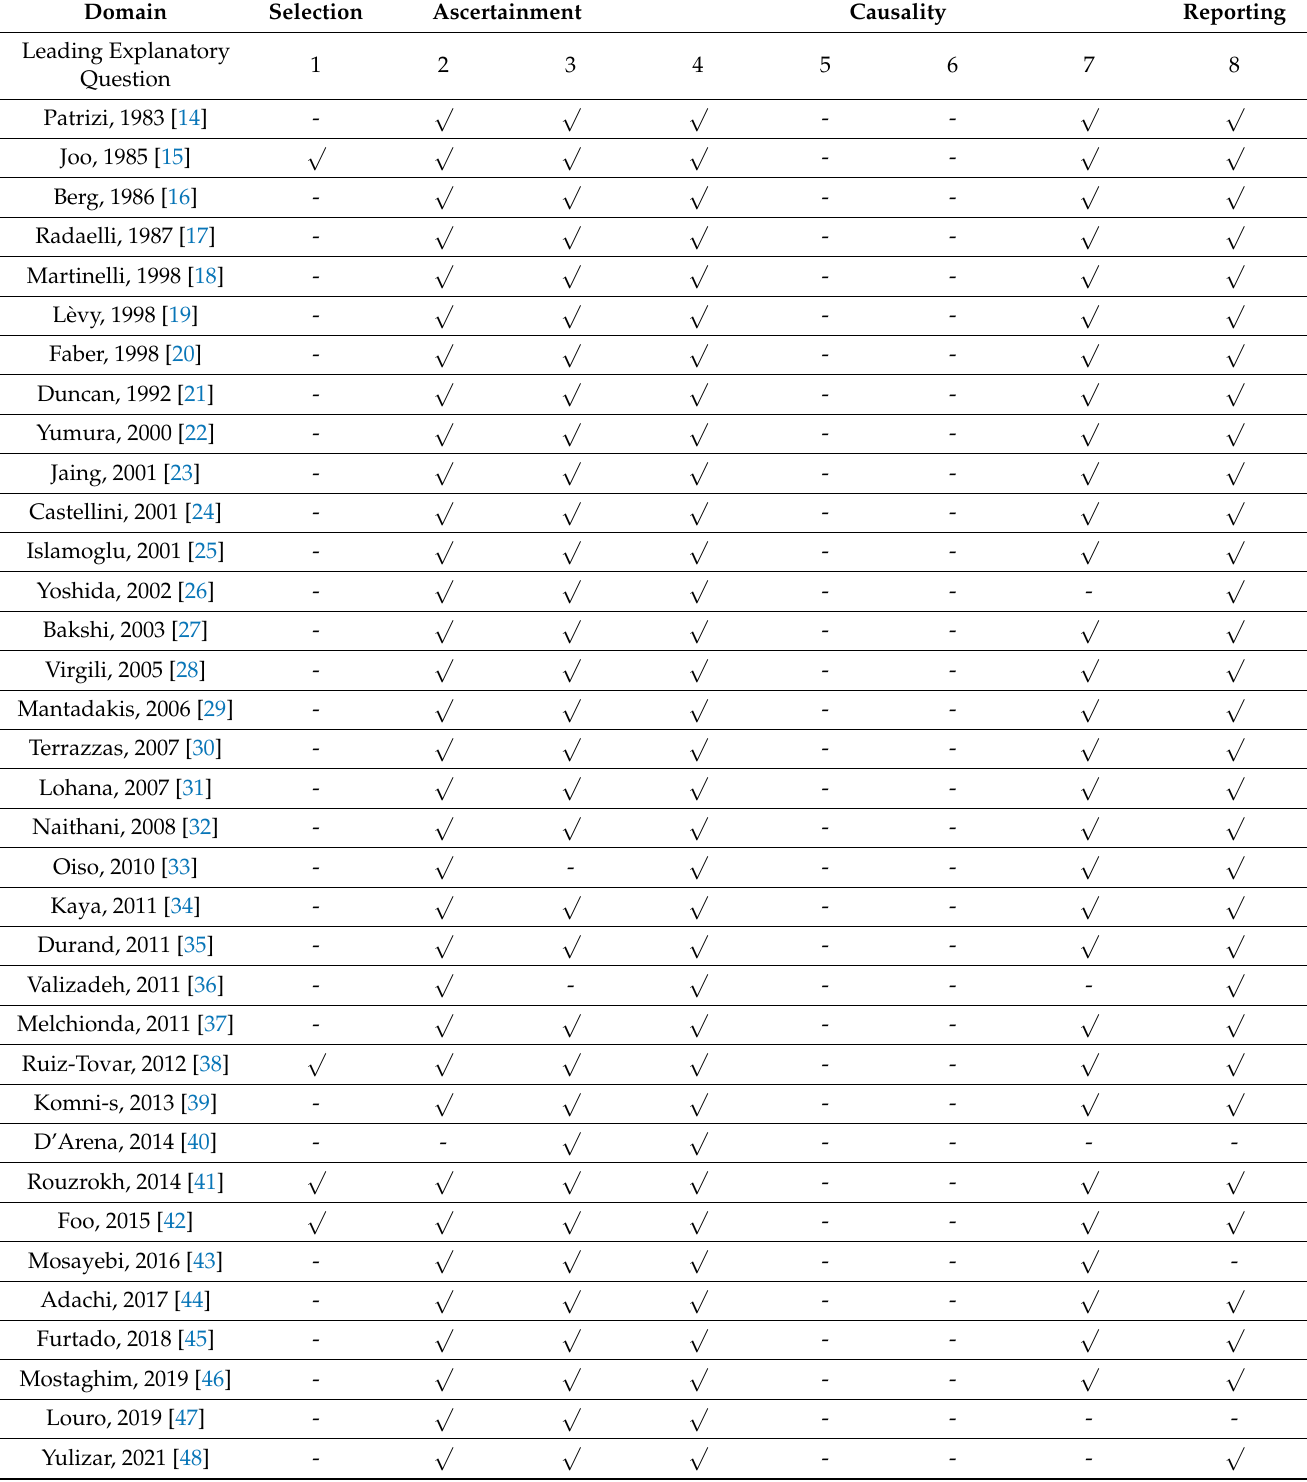
Table 3. Methodological quality of studies